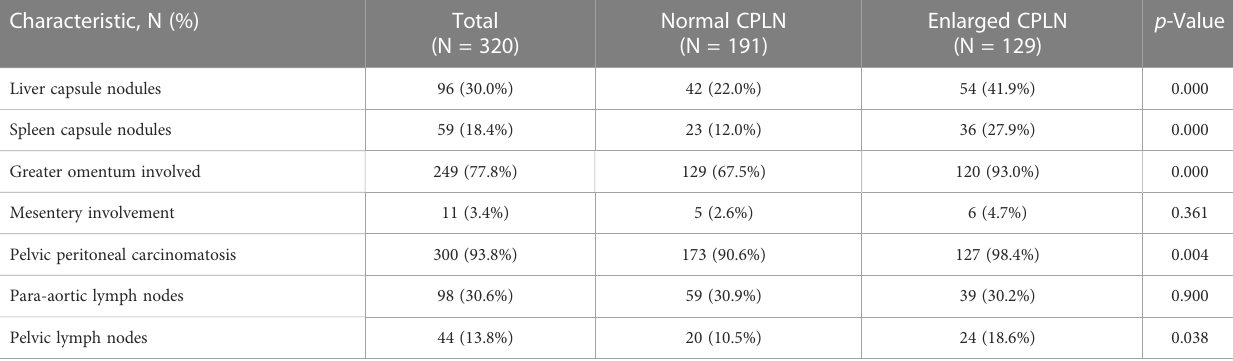
p -Value Normal CPLN Enlarged CPLN (N = 320) (N = 191) (N = 129)